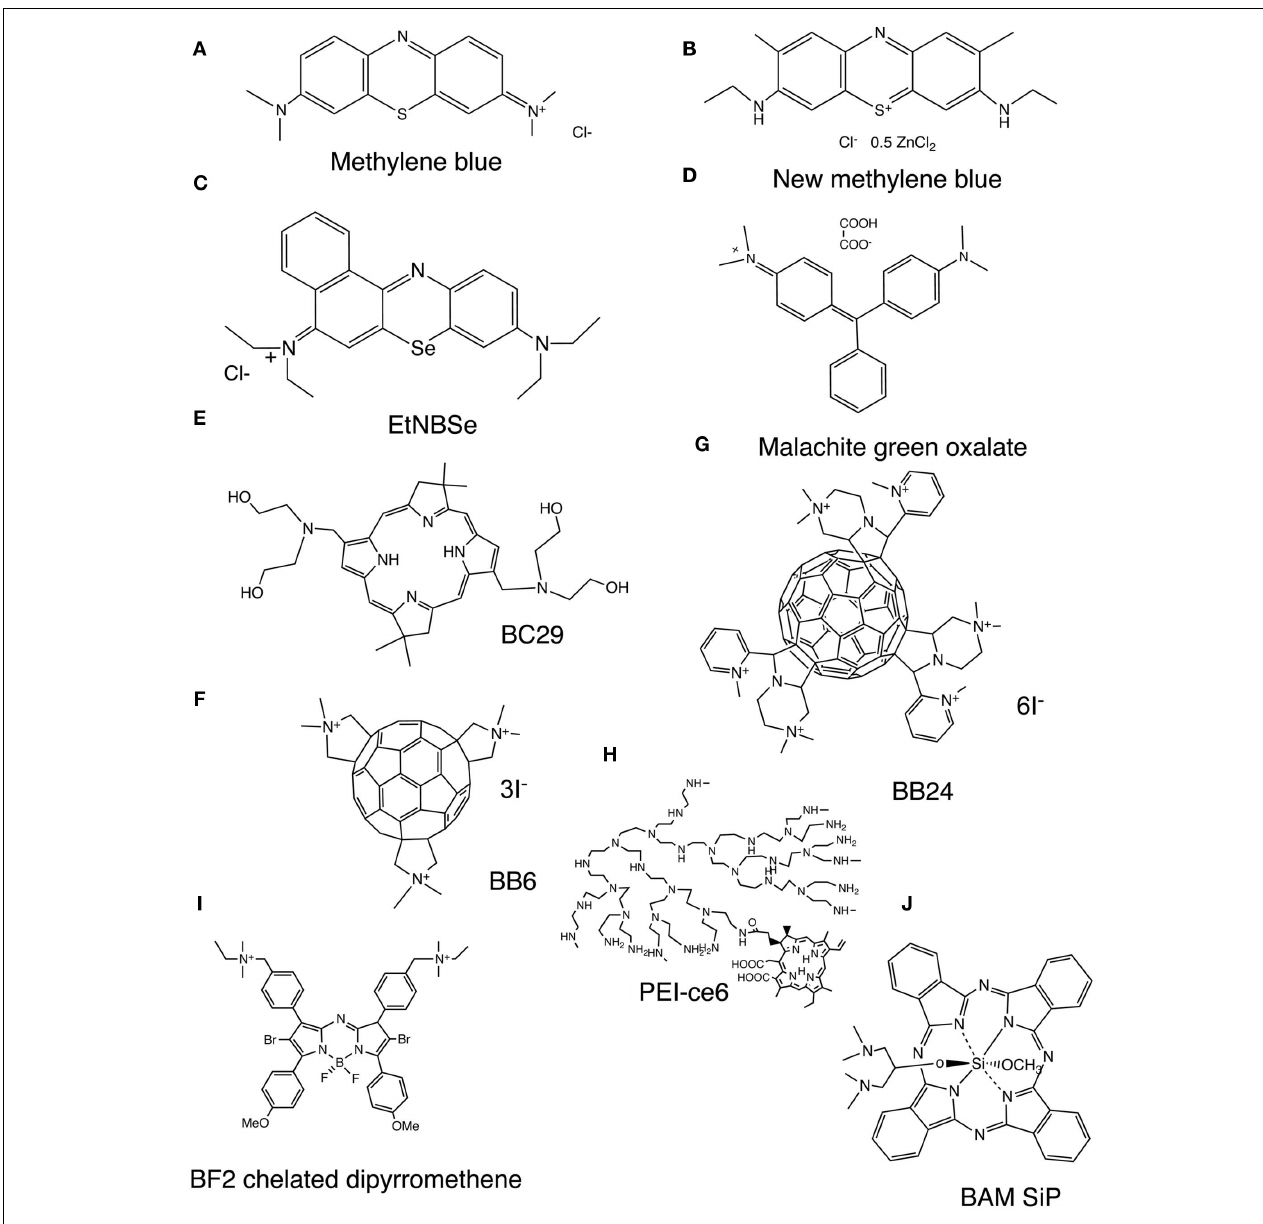
(H) . Conjugate between polyethylenimine and chlorine (e6), PEI-ce6 (Tegos et al., 2006); (I) , BF2 Chelate of N -(4-(4-Bromo-2- (4-bromo-3-(4-((diethyl(methyl)-ammonio)methyl)phenyl)-5-(4- methoxyphenyl)-1H-pyrrol-2-ylimino)-5-(4-methoxyphenyl)-2H-pyrrol-3- yl)benzyl)- N -ethyl- N -methylethanaminium iodide (Frimannsson et al., 2010); (J) , 1,3- bis (dimethylamino)-2-propoxy-methoxy silicon phthalocyanine, BAM-SiPc (So et al., 2010).